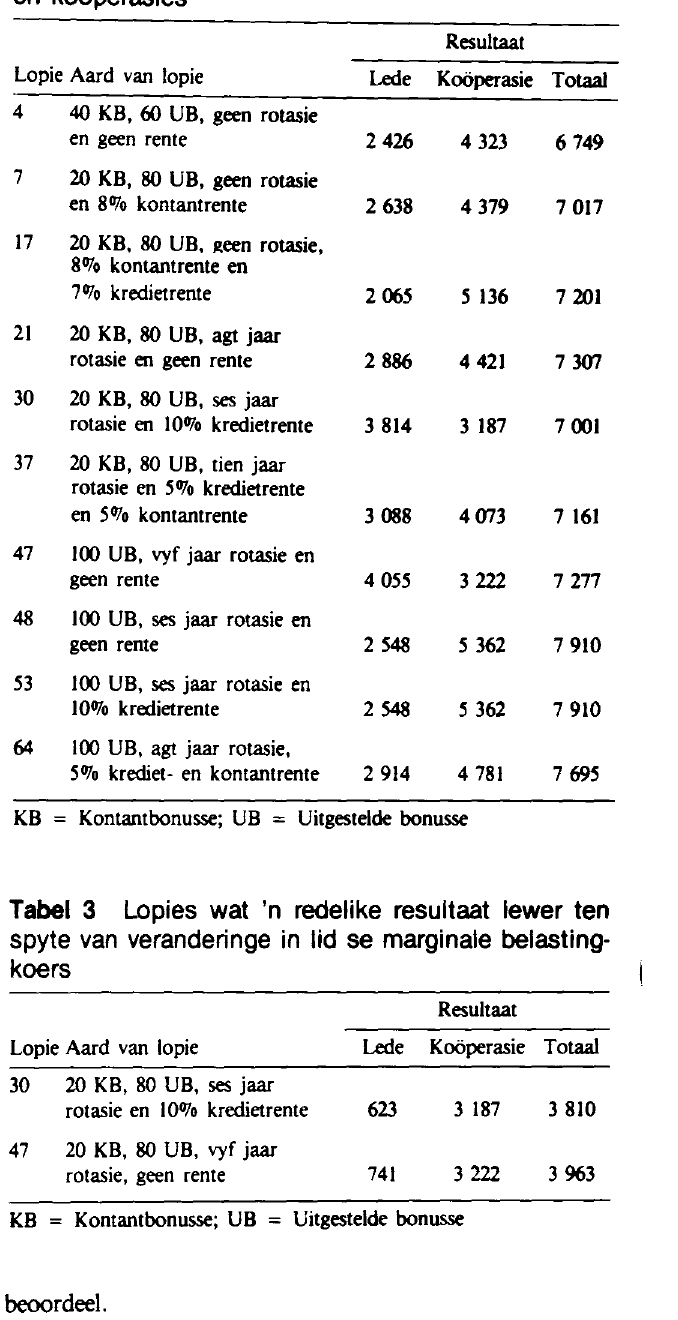
Lopies met 'n redelike resultaat vir beide lede en koOperasies